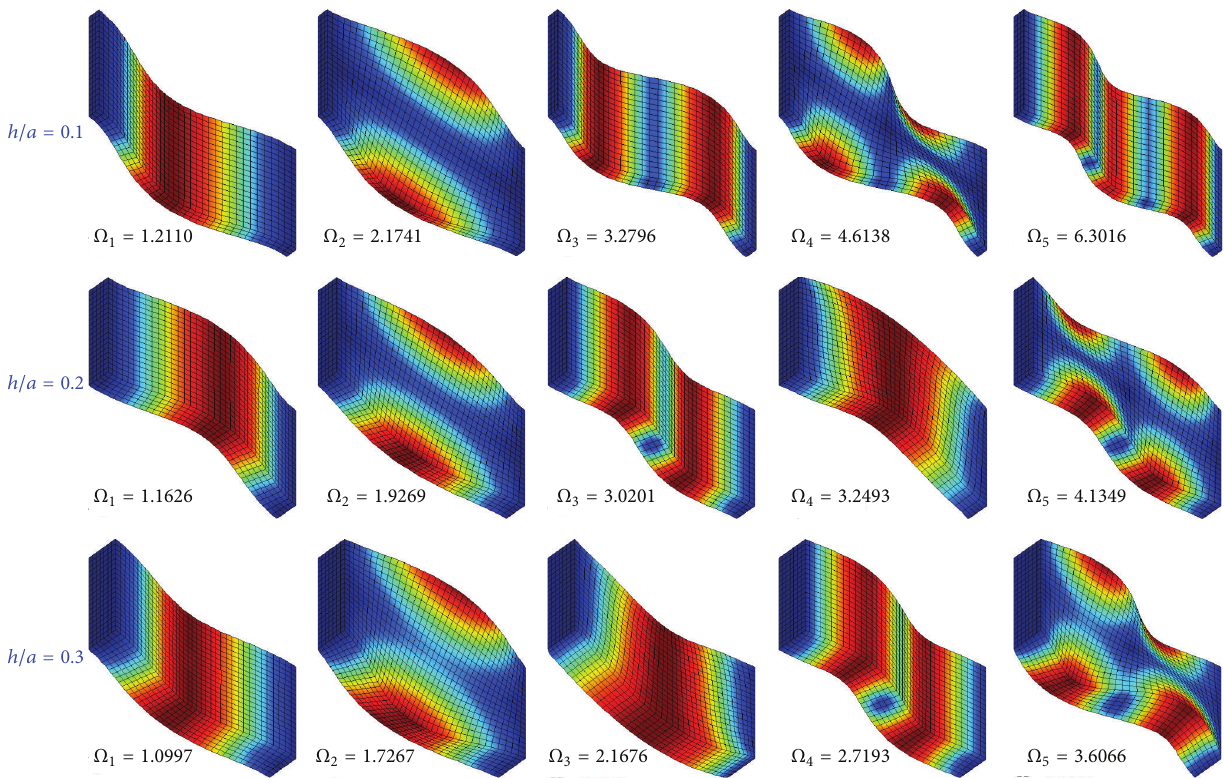
Figure 2: Mode shapes of an orthotropic plate with FCFC boundary conditions and various thickness-length ratios. Table 4: Comparison of frequency parameters Ω = 𝜔𝐿√𝜌/𝐸 of a thick open cylindrical shell with different boundary conditions ( 𝐿 = 1 m, 𝑅/𝐿 =